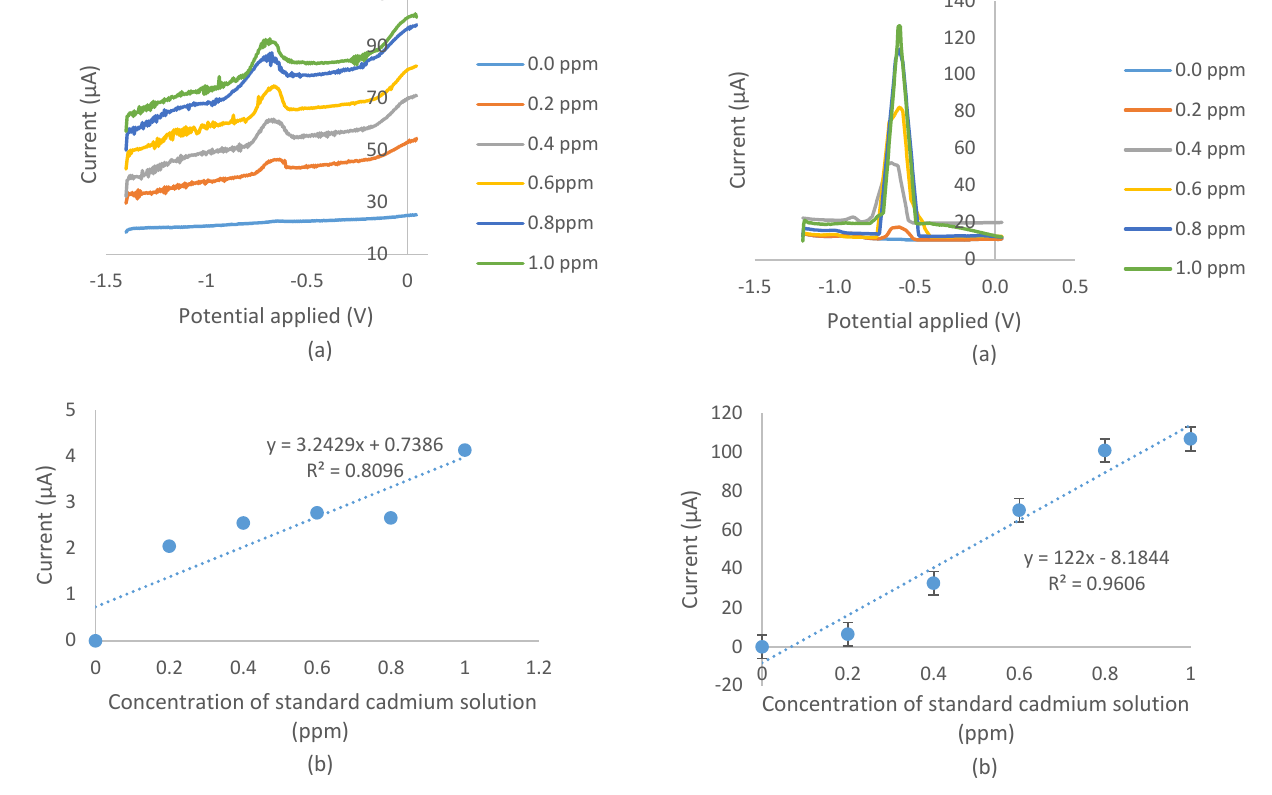
Figure 5. (a) Voltammogram for the series of standard cadmium solutions in an 0.01M acetate buffer with a pH of 4.5, a − 1 .